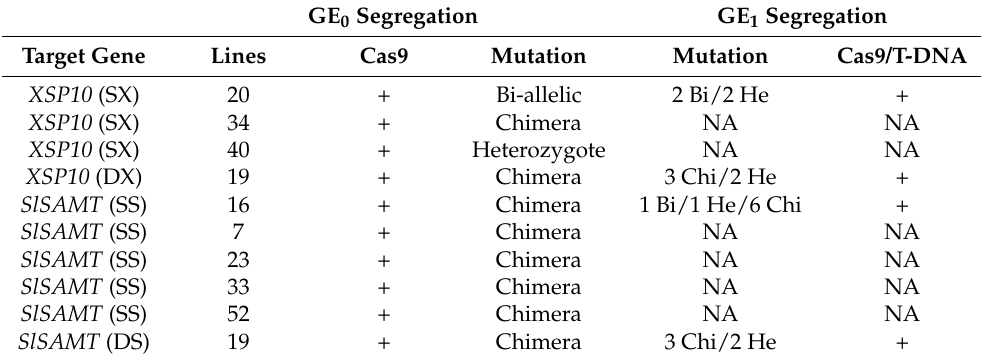
Table 2. Segregation of CRISPR/Cas9-edited lines in GE 1